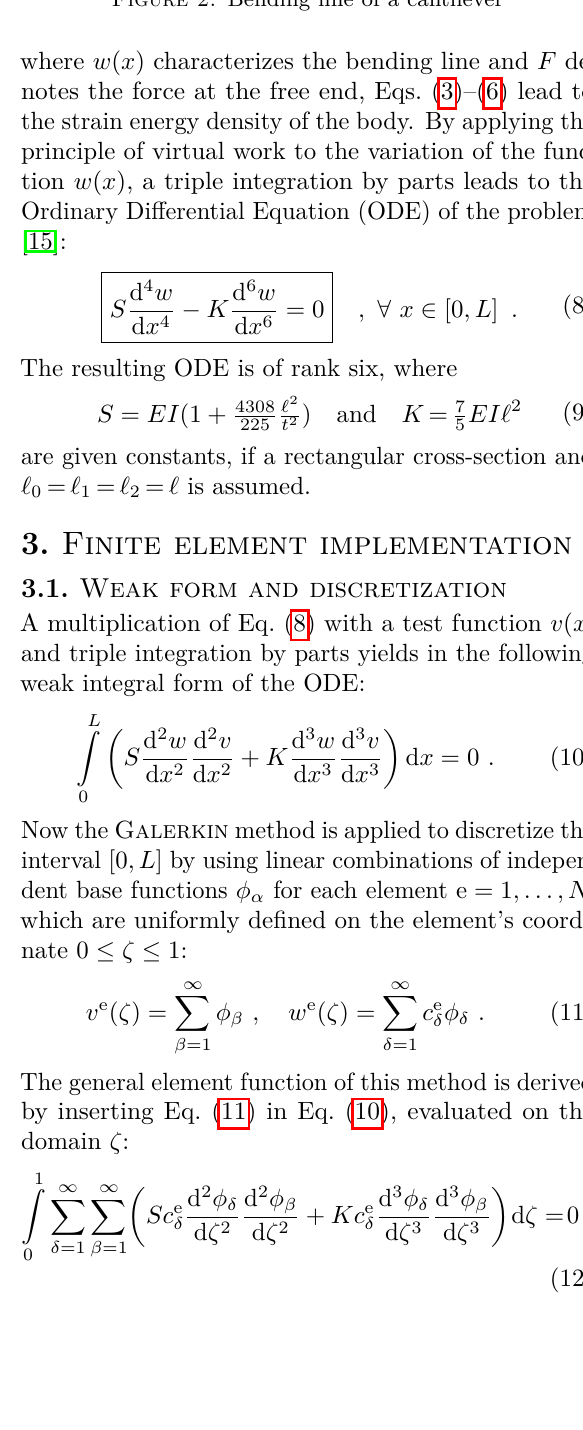
Figure 2. Bending line of a